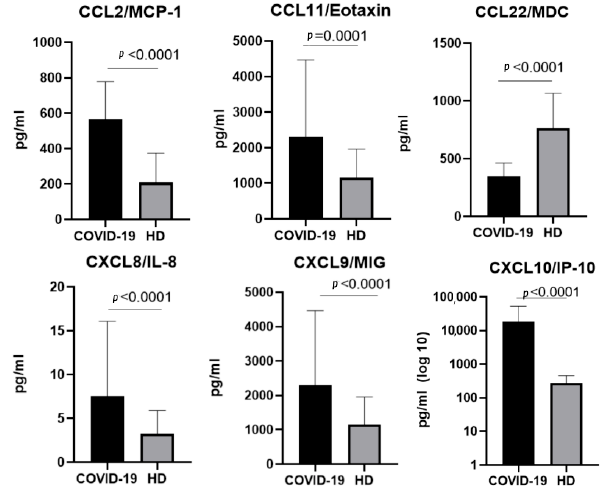
Figure 3. A comparison of the concentrations of the chemokines in the plasma of individuals in- fected with the Delta variant of SARS-CoV-2 in the acute stage (COVID-19), n = 78 and in healthy donors (HD), n = 51. The concentrations are presented in pg/mL plots representing medians with interquartile ranges. Only chemokines with a statistically significant difference are presented.